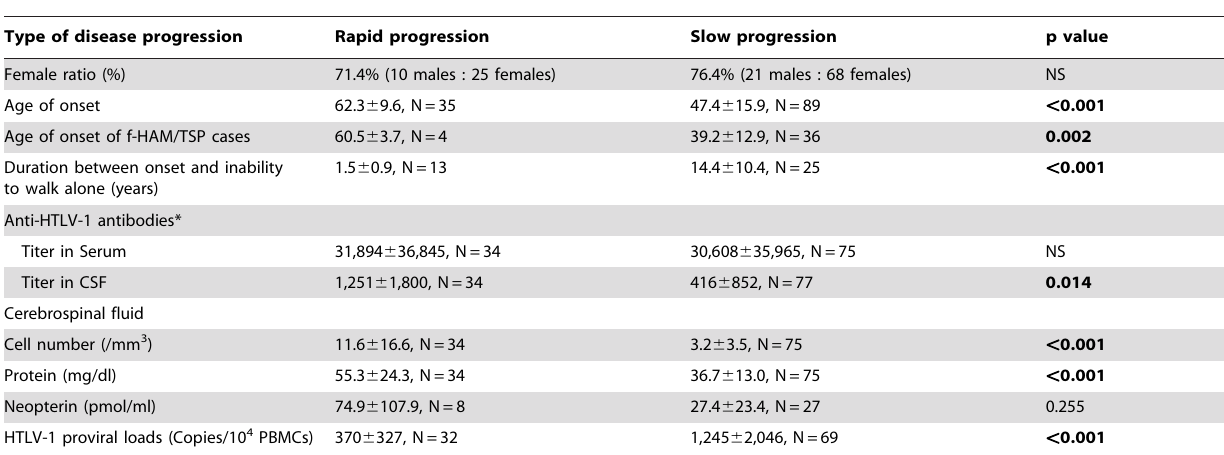
Table 3. Clinical and laboratory findings of sporadic HAM/TSP with rapid/slow disease progression.